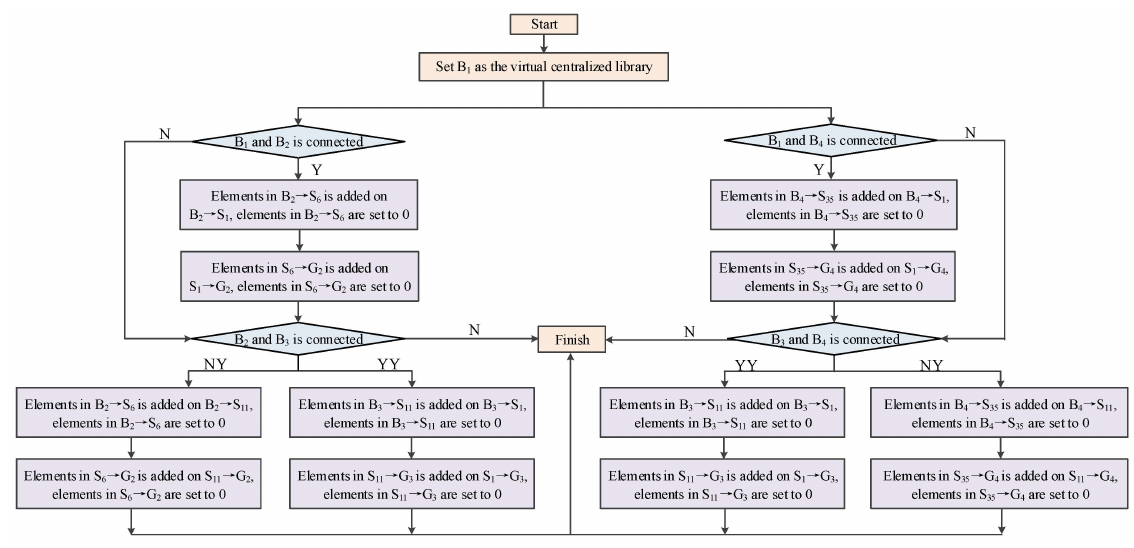
Figure 6. Correlation matrix adjustment process based on the tie line